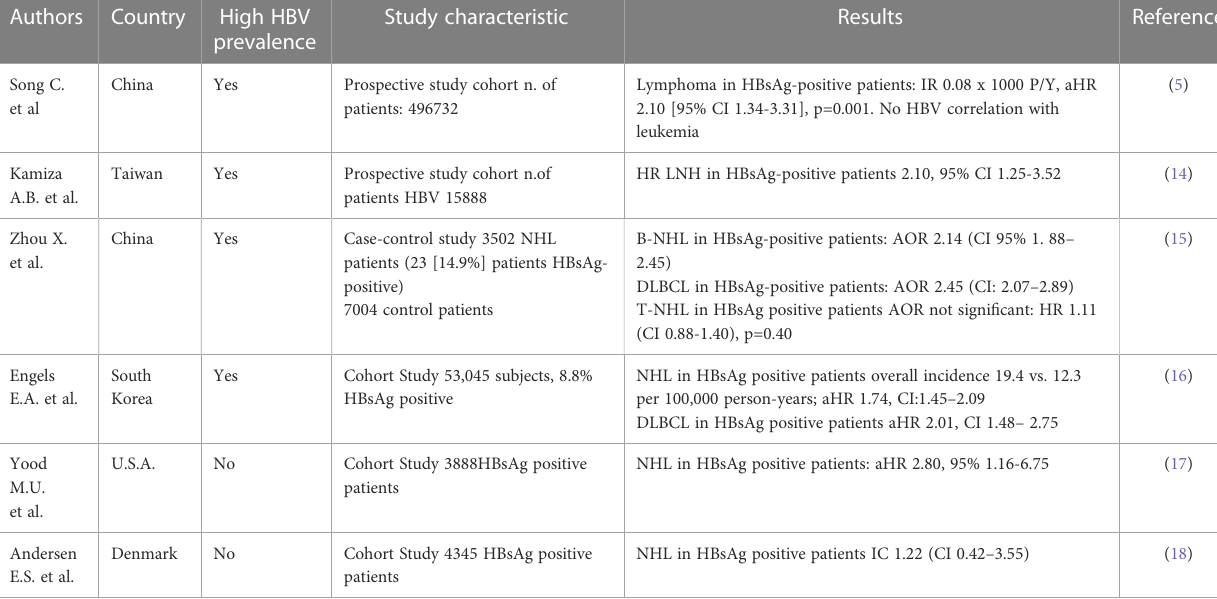
TABLE 1 Summary of studies addressing the correlation between HBV infection and hematological